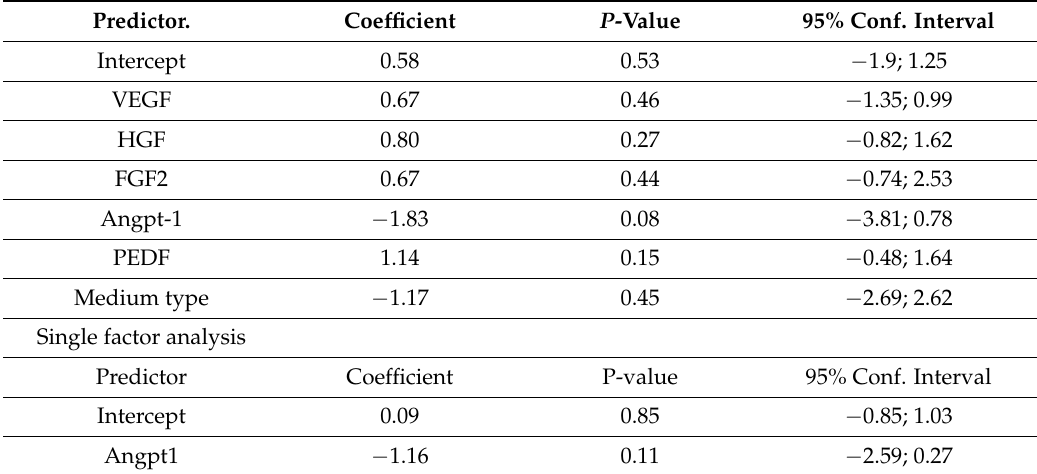
Table 2. Prediction model for MSC-CM sample potency to stimulate human dermal fibroblast migration; n = 24 for train group, n = 12 for validation group.